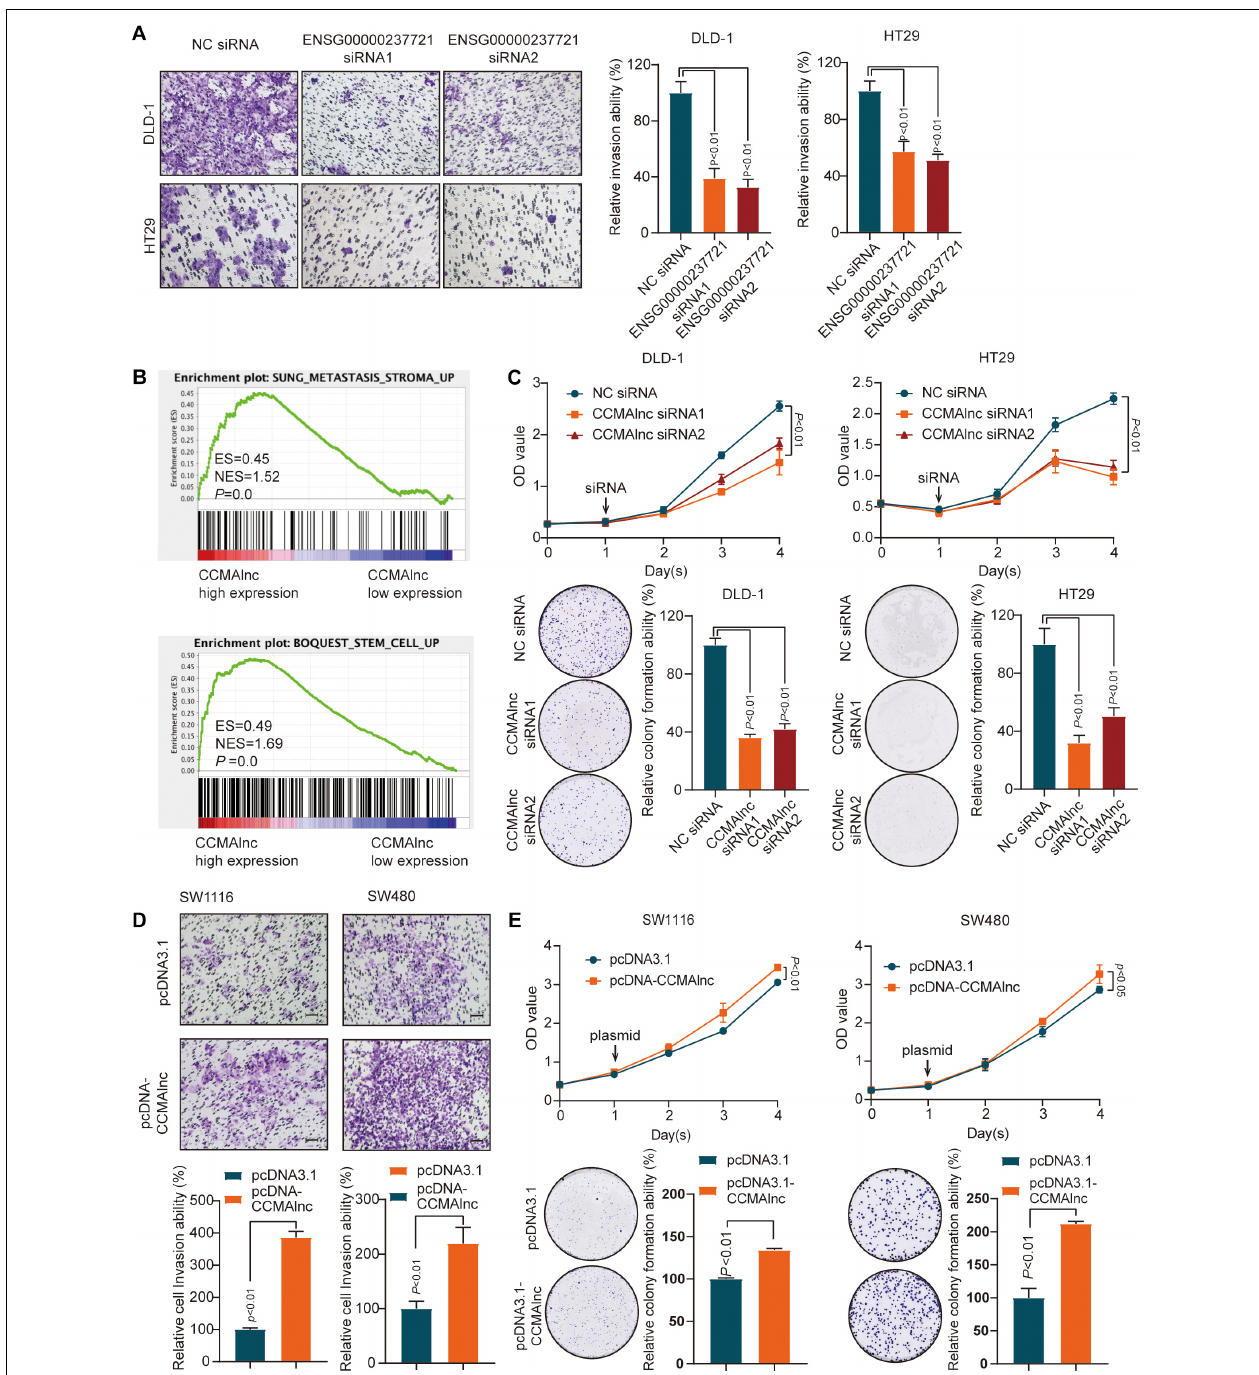
FIGURE 2 | CCMAlnc promotes the proliferation and invasion of CRC cells. (A) A Matrigel invasion assay was performed in CRC cells after transfection of control siRNA and CCMAlnc siRNA. The invading cell numbers on each filter were counted. Data were plotted by defining the percentage of control siRNA-transfected cells as 100%. N = 3. Scale bars, 50 µ m. (B) GSEA was performed to compare the CCMAlnc high-expression group (red) against the CCMAlnc low-expression group (blue) of CRC patients from the TCGA database. (C) CCMAlnc siRNA significantly reduced cell proliferation and anchorage-dependent growth, as detected by CCK8 proliferation and colony formation assays in DLD-1 and HT29 cells. (D) CCMAlnc increased cell proliferation and anchorage-dependent growth, as detected by CCK8 proliferation and colony formation assays in SW1116 and SW480 cells. (E) Overexpression of CCMAlnc promoted invasion in SW1116 and SW480 cells. The invading cell numbers on each filter were counted. Data were plotted by defining the percentage of pcDNA3.1-transfected cells as 100%. N = 3. Scale bars, 50 µ m.